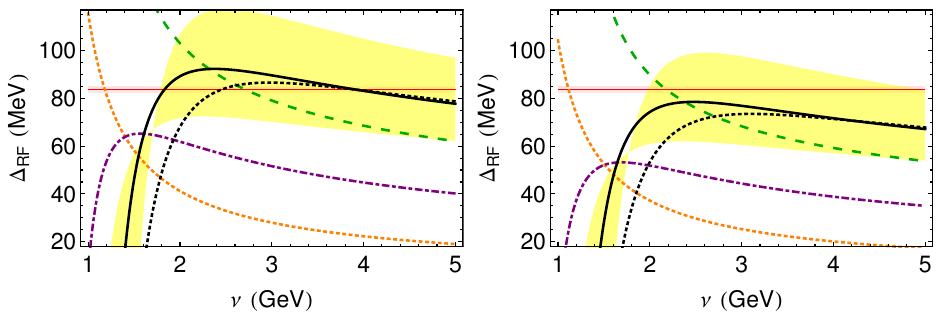
Figure 6 . As in (cid:12)gure 5 changing the central value of (cid:11) s and the yellow band to the values in eq. (3.7).